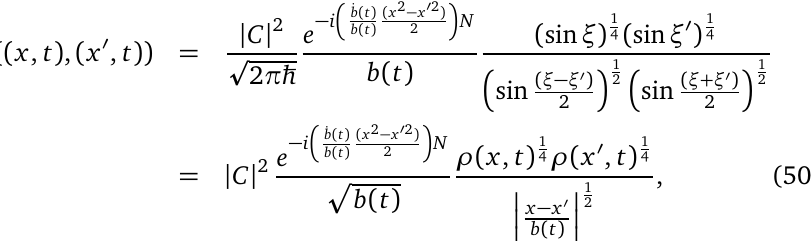
(( x , t ) , ( 0,0 )) | (right), as a function of x and t . The 1 = 1, ω = 0.5, N = 0 1